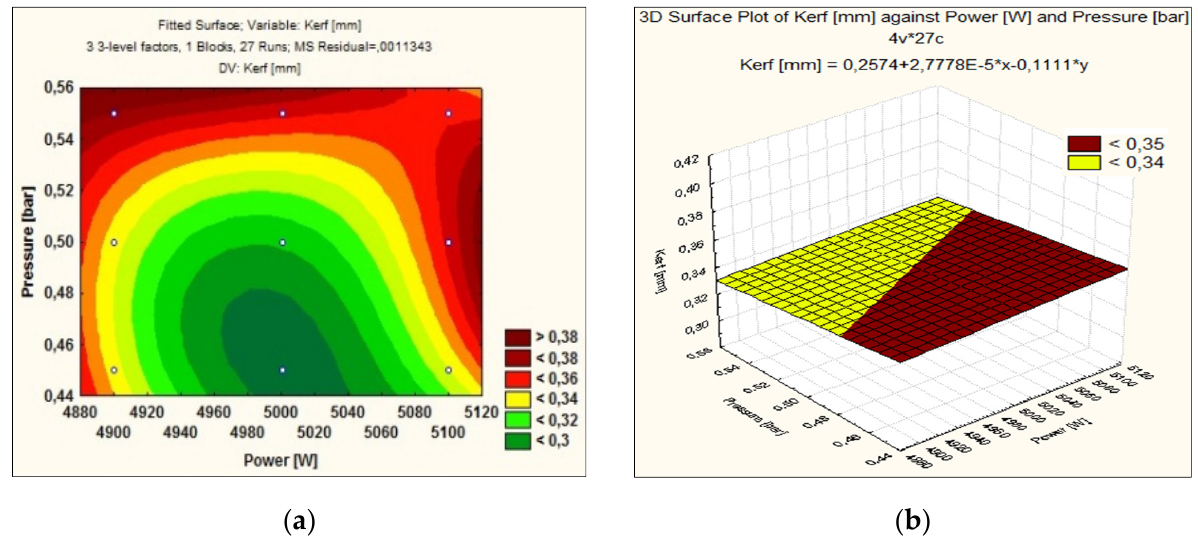
Figure 8. ( a ) Linear predictive model of influence factors; ( b ) Linear dependence of cutting width as a function of laser power and gas